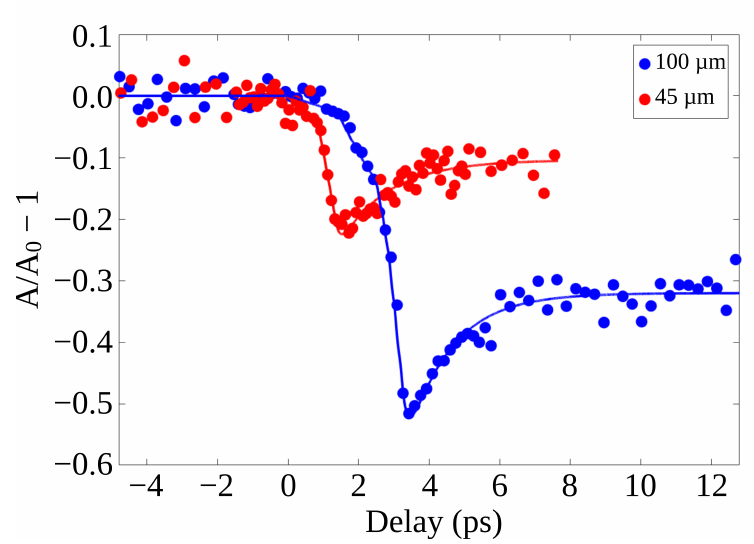
Figure 5. Normalized asymmetry as a function of time delay for THz pump of fundamental wave- lengths of 45µm (red) and 100µm (blue) as a function of time delay. The unusually long demagneti- zation time is a consequence of the THz pulse length of about 1.5 and 3.3ps respectively. The exact shape of the pump pulse gives rise to the varying slope in the demagnetization